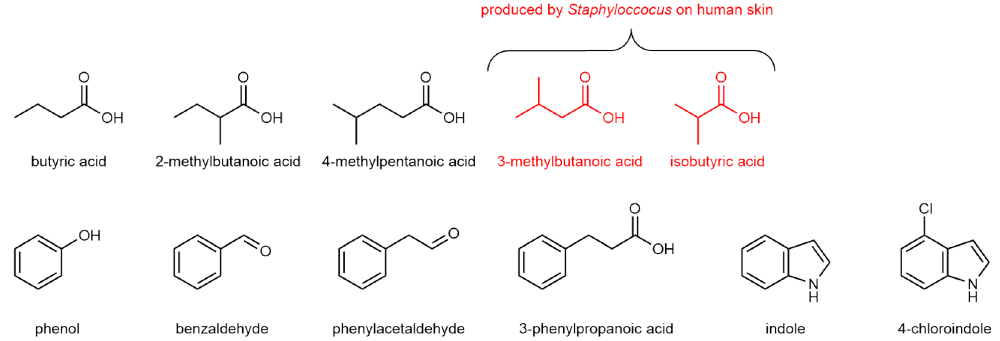
Figure 4. Volatile organic compounds derived from microbial metabolism of hoopoe uropygial secretions [86]. Generation of malodorous fatty acid shows similarities to the compounds produced by cutaneous bacteria on human skin [156].